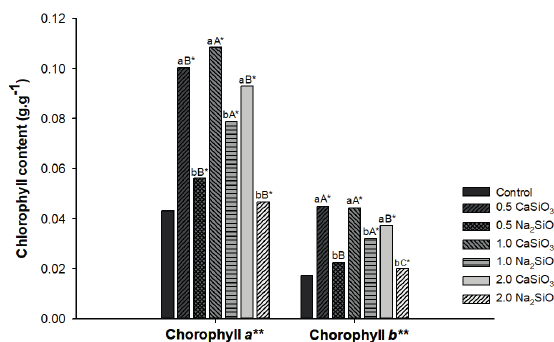
Figure 4 - Chlorophyll a and b content (g g -1 ) of B. zebrina leaves as a function of different sources and concentrations (mg L -1 ) of silicates after 100 days of in vitro growth. Means followed by ‘*’ are different from the control by Dunnet’s multiple range test at 5% probability; lowercase letters refer to the unfolding of the sources within each concentration, the means with distinct lowercase letters are different by Tukey’s multiple range test at 5% probability; Capital letters refer to the unfolding of concentrations within each source, the means with distinct capital letters are different by Tukey’s multiple range test at 5% probability. ‘**’ Indicate no significant statistical interaction between the sources and